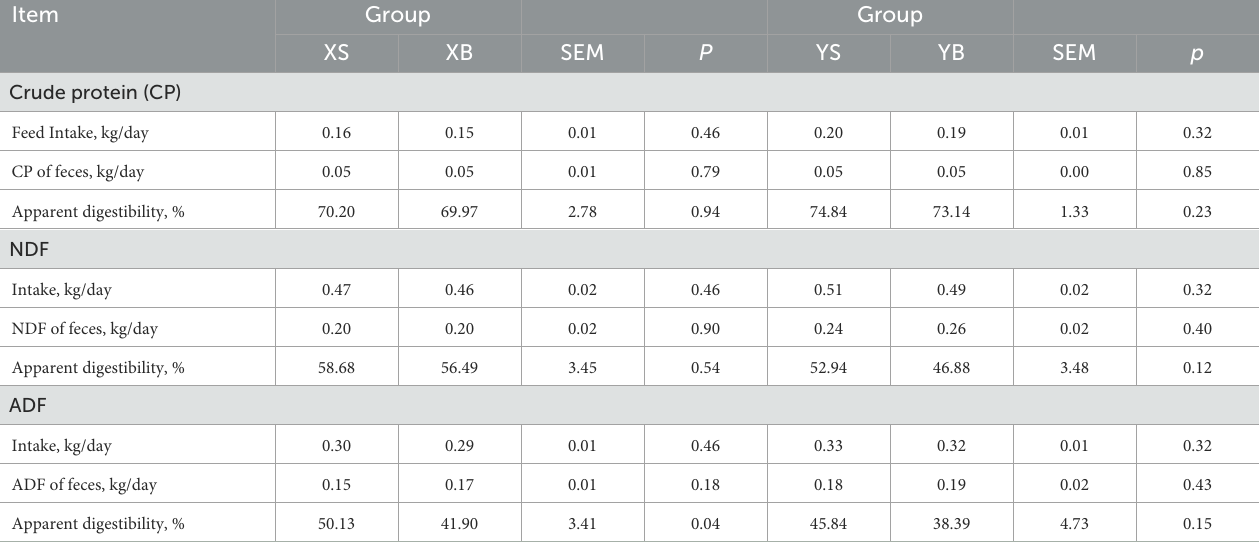
TABLE 3 Apparent digestibility of nutrients by sheep and goats fed on the same diet.